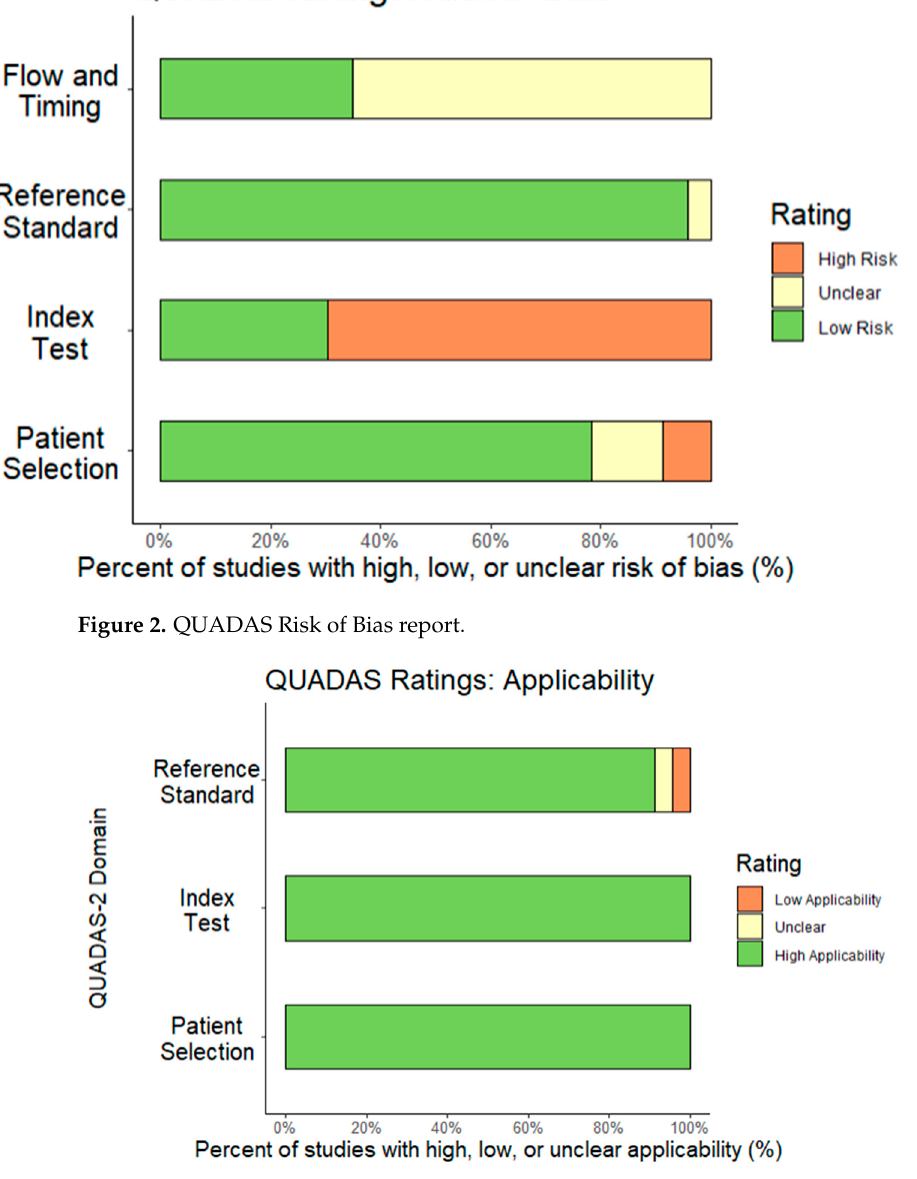
Figure 3. QUADAS Applicability report.